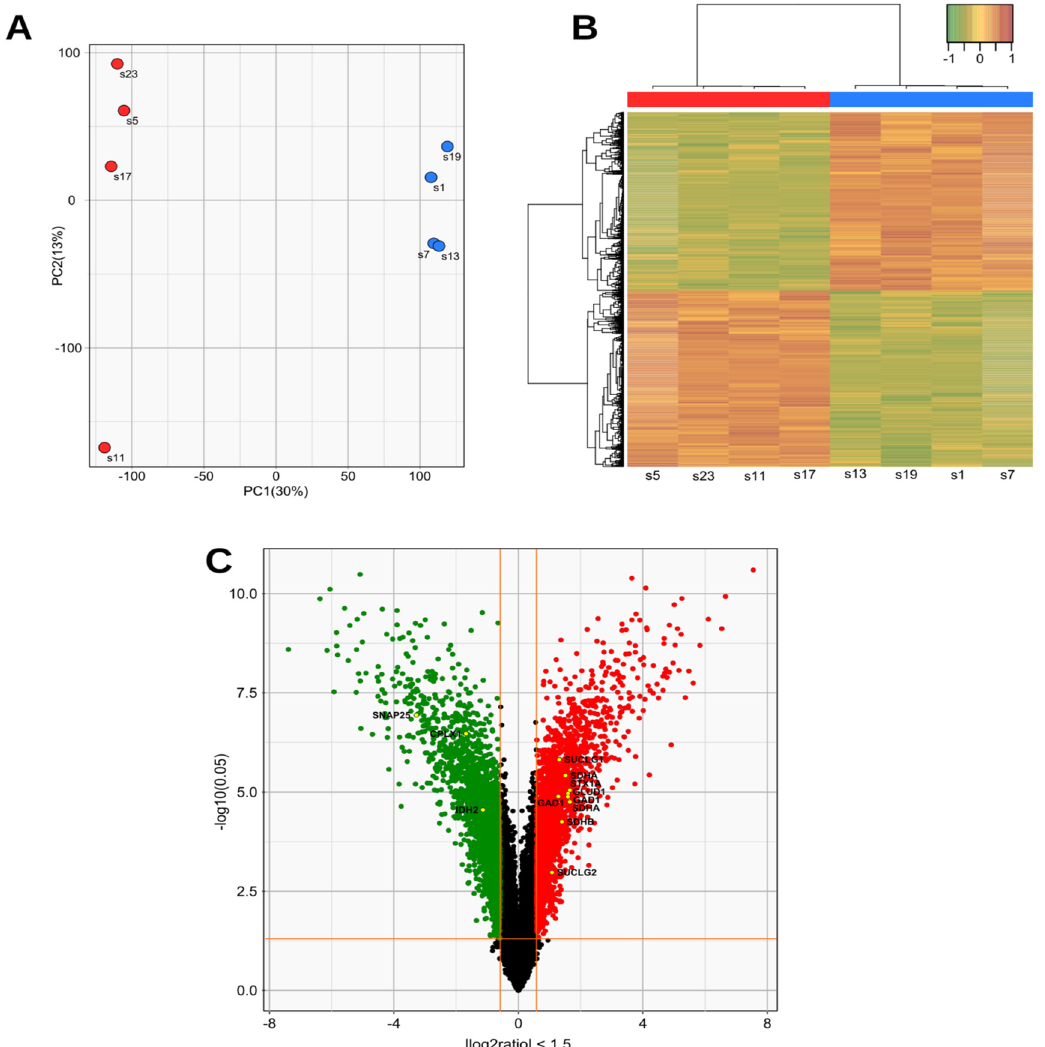
Figure 3. Gene expression profiling of mutant cells. ( A ) Principal component analysis (PCA) and unsupervised clustering of MT (red) vs Ctrl cells (blue). ( B ) Heatmap diagram of two-way hierarchical clustering analysis of the 4943 probes, showing different expression levels with a p -value ≤ 0.05 and abs (FC) ≥ 1.5. Red and green colours represent an expression level above or lower than the mean, respectively. The X-axis represents samples with, from the left to the right, control cells compared to 98% MT cells (n = 4) while the Y-axis represents Illumina probes. ( C ) Volcano plot representation of the differentially expressed genes in a pairwise comparison of control vs 98% MT cells. The significant cut-off was set at a p -value ≤ 0.05 and abs (FC) ≥ 1.5. Differentially expressed genes annotated as glutamate-glutamine metabolism, GABA, and TCA cycle in the REACTOME pathway database (see Table 1) are labelled with their corresponding gene symbols. Table 1. Functional classification analysis of repressed or overexpressed genes in MELAS cells ac- cording to the REACTOME pathway database.